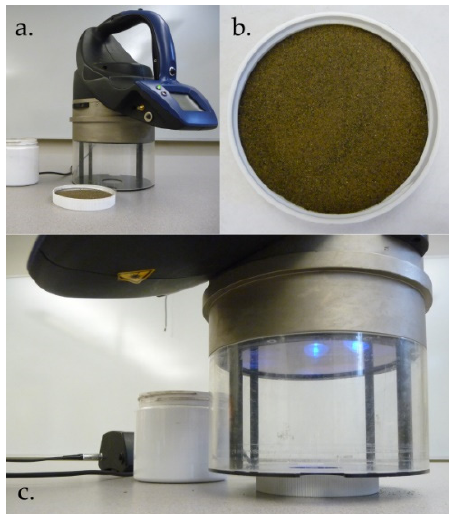
Figure 1. Multiplex MX3 sensor ( a ), soil disposed in a plate (container lid) ready for sensing ( b ), and